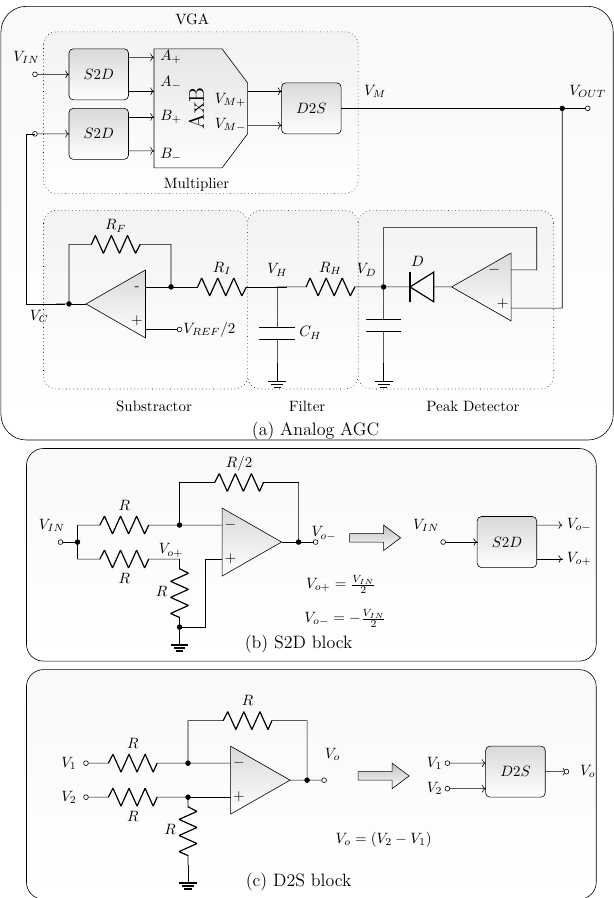
Figure 4. Proposed AGC for this